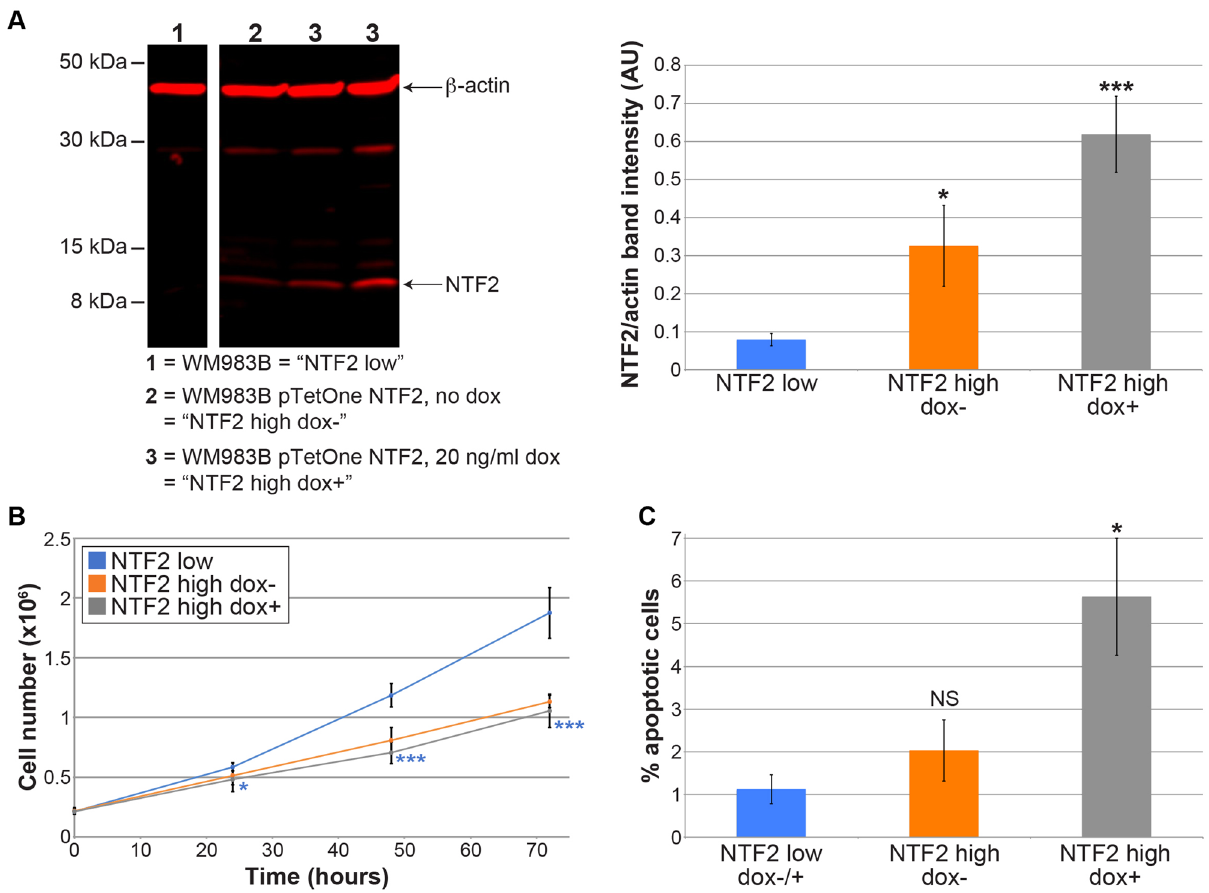
Figure 1. Inducing NTF2 expression in metastatic melanoma reduces cell proliferation and increases apoptosis. (A) Metastatic melanoma cells (WM983B) were stably transfected with a doxycycline-inducible NTF2 construct (pTetOne NTF2). These cells were treated with different concentrations of doxycycline for 48 h and cell lysates were analyzed by NTF2 and actin immunoblots. White space delineates cropped lanes from the same blot (Fig. S6A for the uncropped blot). For simplicity, “NTF2 low” refers to the parent cell line WM983B, “NTF2 high dox-” refers to the transfected cell line grown without doxycycline, and “NTF2 high dox + ” refers to the transfected cell line treated with 20 ng/ml doxycycline. NTF2 band intensities were normalized to actin band intensities and averaged for 7–8 independent samples per condition. Error bars are SEM. One-way ANOVA followed by Dunnett’s multiple comparisons test with *p < 0.05, and ***p < 0.005. The 20 ng/ml doxycycline concentration was selected for all experiments because it induces the greatest reduction in nuclear size. (B) 2 × 10 5 cells were plated in 6-well plates. At 24, 48, and 72 h, cells were trypsinized, stained with trypan blue, and counted. Data are from 3–4 independent experiments and two replicates per experiment. Error bars are SD. One-way ANOVA followed by Dunnett’s multiple comparisons test with *p < 0.05 and ***p < 0.005. The statistical comparisons are for NTF2 high dox-/+ compared to NTF2 low. (C) Cells were plated at 30% confluency. After 48 h, cells were stained for activated caspase-3/7. The number of positive staining cells and total cells were counted to calculate the percent of apoptotic cells. For each condition, 8–16 coverslips were examined and 20–632 cells (140 cells on average) were counted per coverslip. Error bars are SEM. One-way ANOVA followed by Dunnett’s multiple comparisons test with *p < 0.05 and NS not These data reveal an inverse correlation between NTF2 expression levels and cell migration potential, and this effect is specific to NTF2 as ectopic mCherry expression did not affect the rate at which metastatic melanoma cells filled the scratch (Fig. S2B). In these experiments we did not inhibit cell division because even low con- centrations of drugs that affect microtubules can impact cell migration 30 . Because filling of the scratch in our wound healing assays might be affected by cell proliferation, we also examined migration of non-dividing indi- vidual cells on the edge of the scratch (Fig. 2D). The NTF2 low cell trajectories were the longest with the NTF2 high dox- and NTF2 high dox + cells exhibiting progressively reduced cell movements (Fig. 2E). Expression of mCherry did not affect the distance traveled by metastatic melanoma cells (Fig. S2C), again indicating that general protein overexpression does not impact cell migration. These data show that titrated increases in NTF2 levels concomitantly decrease cell motility.